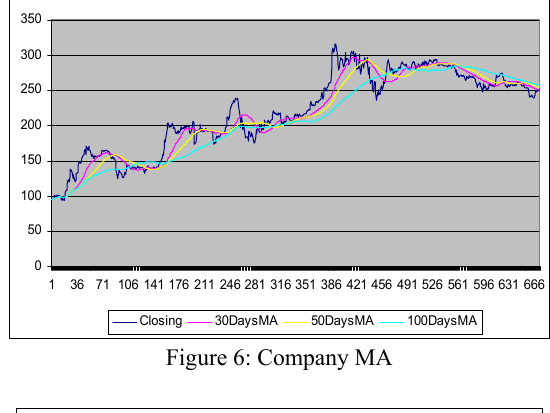
Figure 6: Company MA